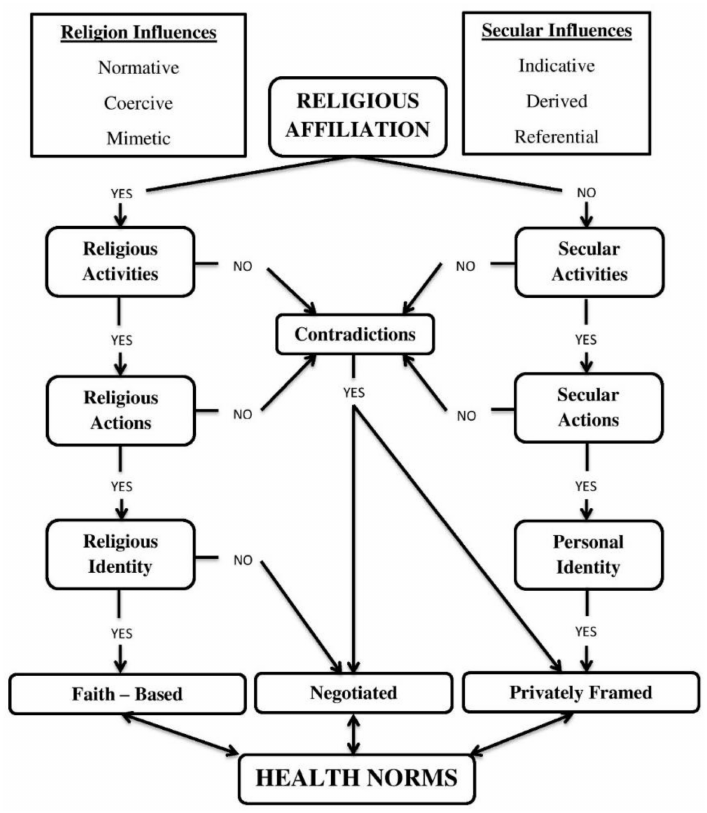
Figure 1. Heuristic Model on Religion Environment Effects on the Framing of Health Norms by